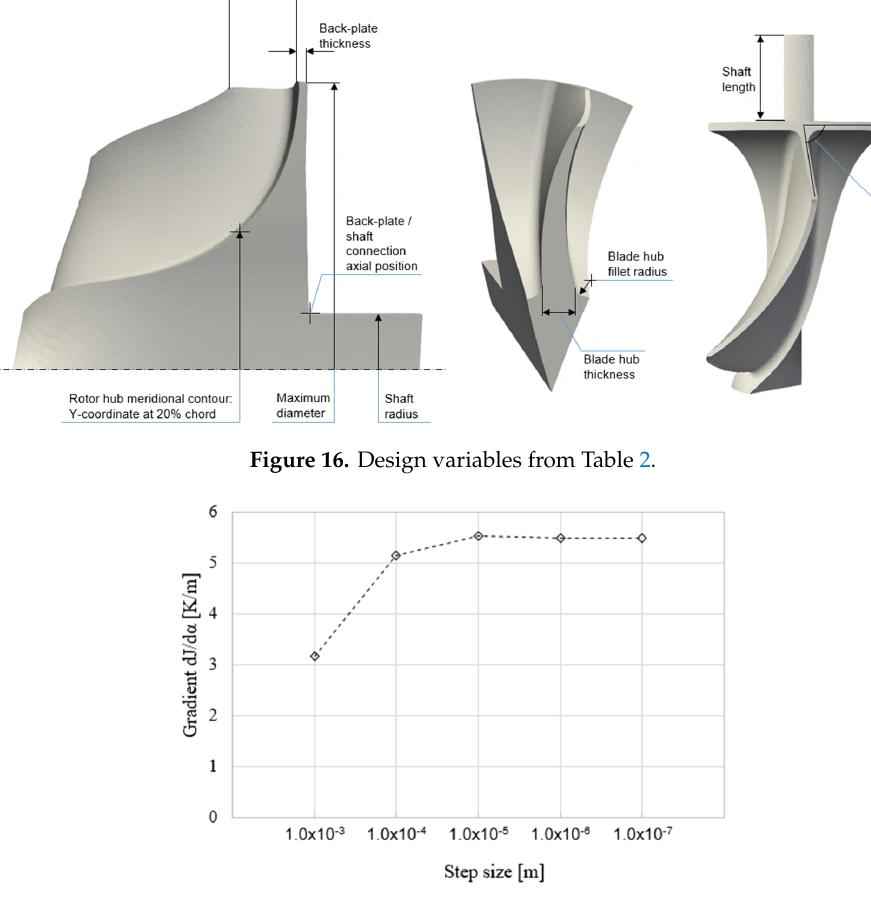
Figure 17. Step size evaluation for the computation of dJ/dα by Finite Differences: Heat Transfer solver, variable 7.